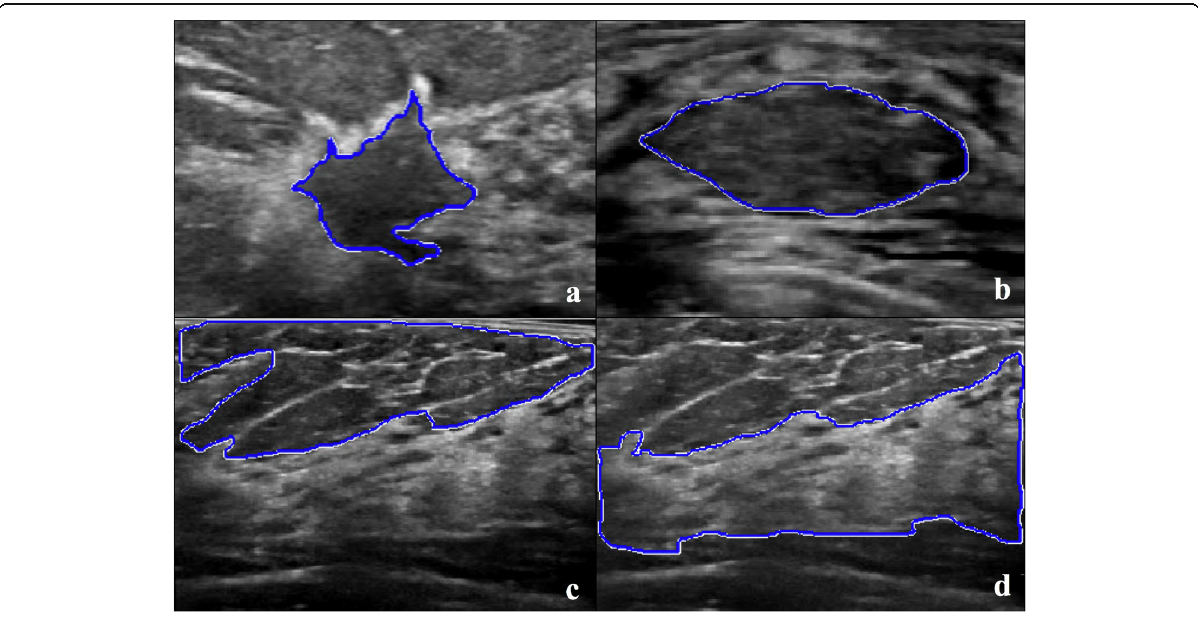
Fig. 1 Axial images obtained with automated breast ultrasound (ABUS). A region of interest was drawn freehand marking the outer edge of the lesion or the maximal continuous area of fat or fibroglandular tissue included in the image. Invasive ductal carcinoma in a 53-year-old patient undergoing screening mammography and ABUS ( a ). Stable benign solid lesion after a 48-month follow-up in a 35-year-old woman undergoing routine control ( b ). Fatty tissue ( c ). Fibroglandular tissue ( d